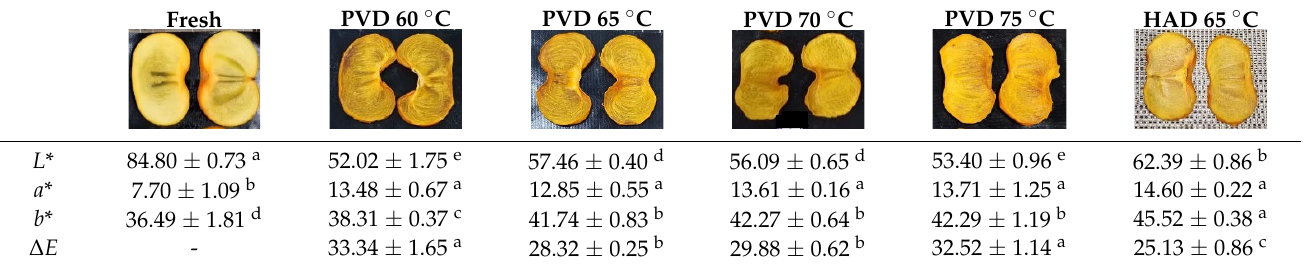
Table 2. The color parameters L *, a *, b * and Δ E of dried persimmon slices under different drying conditions.